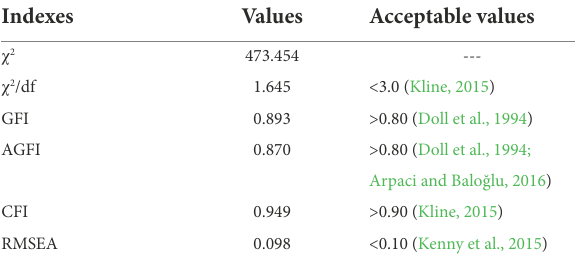
TABLE 6 KMO and Bartlett’s test.